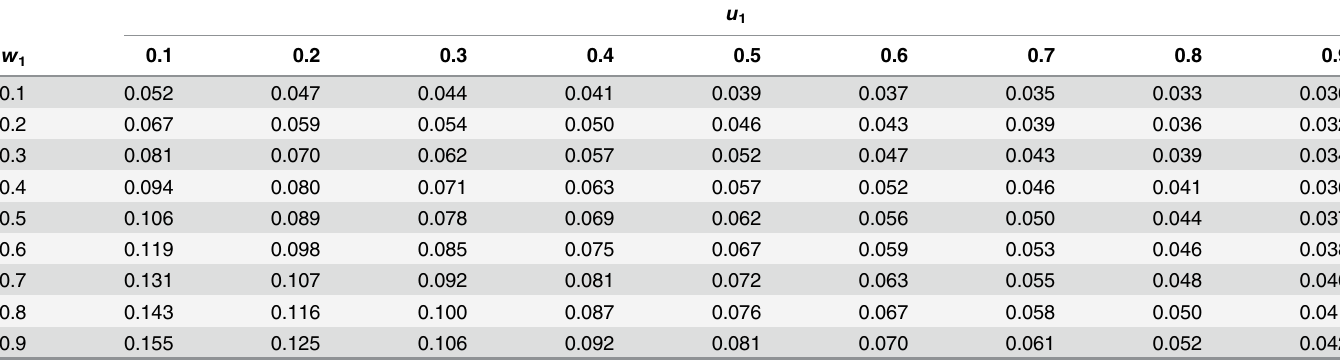
Table 1. Worst case type I error for various choices of weights and information fractions. Nominal level α = 0.025